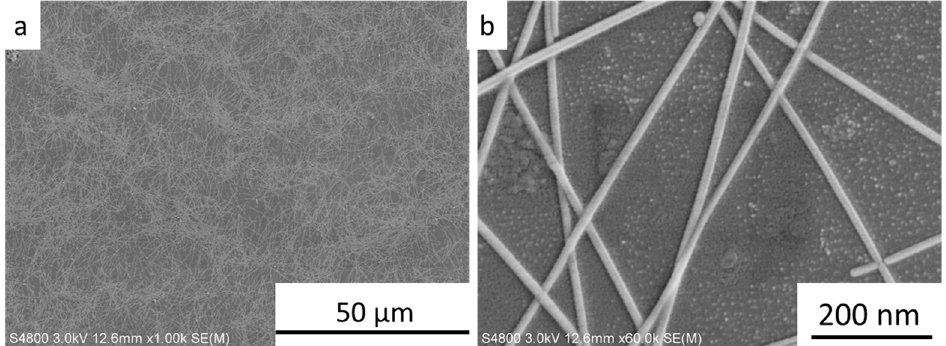
Figure 1. SEM images of commercial AgNWs at low ( a ) and high ( b ) magnification.